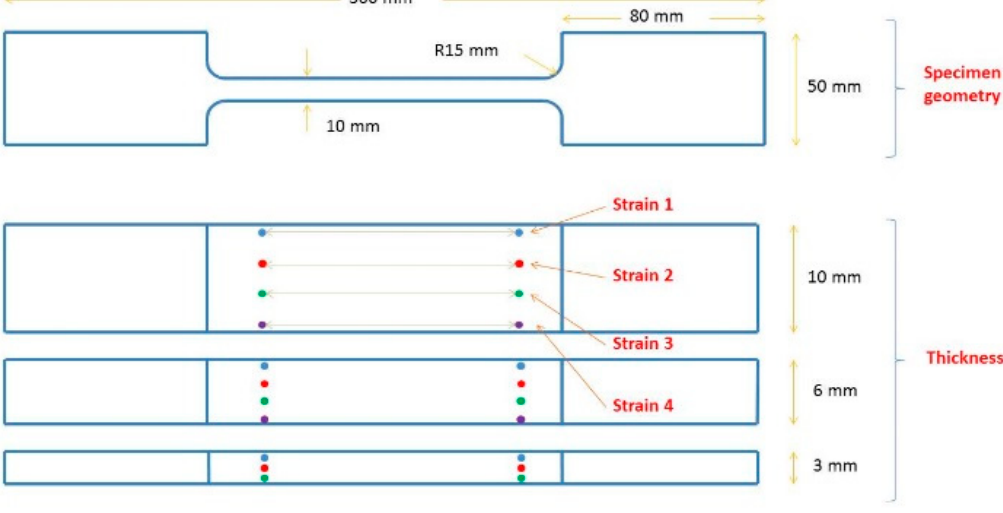
Figure 4. Geometry of the tensile specimens.